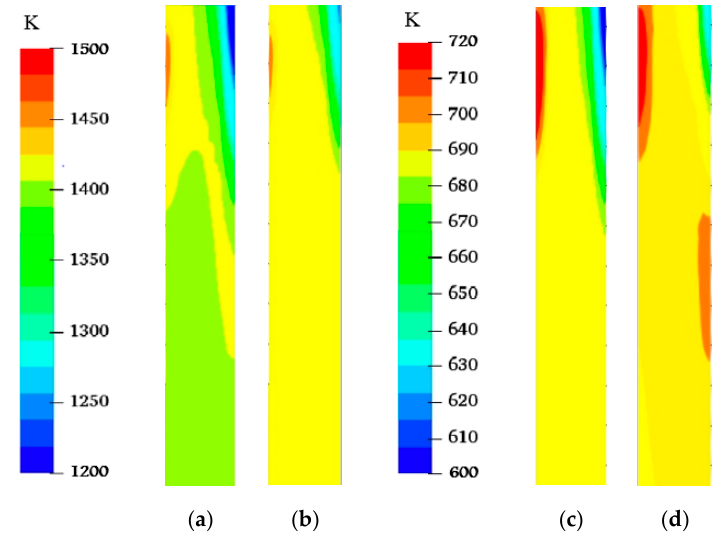
Figure 11. The time-average quasi-steady air temperature distributions in the opening (0.11–0.35 m). The energy fluxes are incident from the left side. ( a ) 100 A and 0.53 g/s; ( b ) 100 A and 0.59 g/s; ( c ) 50 A and 0.69 g/s; ( d ) 50 A and 0.79 g/s.